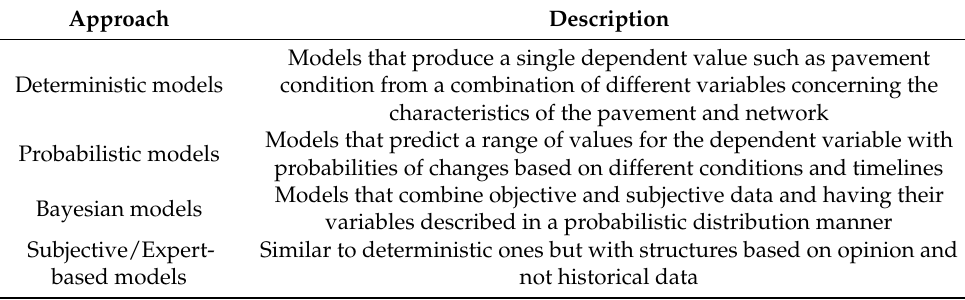
Table 1. Overview of typical types of pavement performance models.